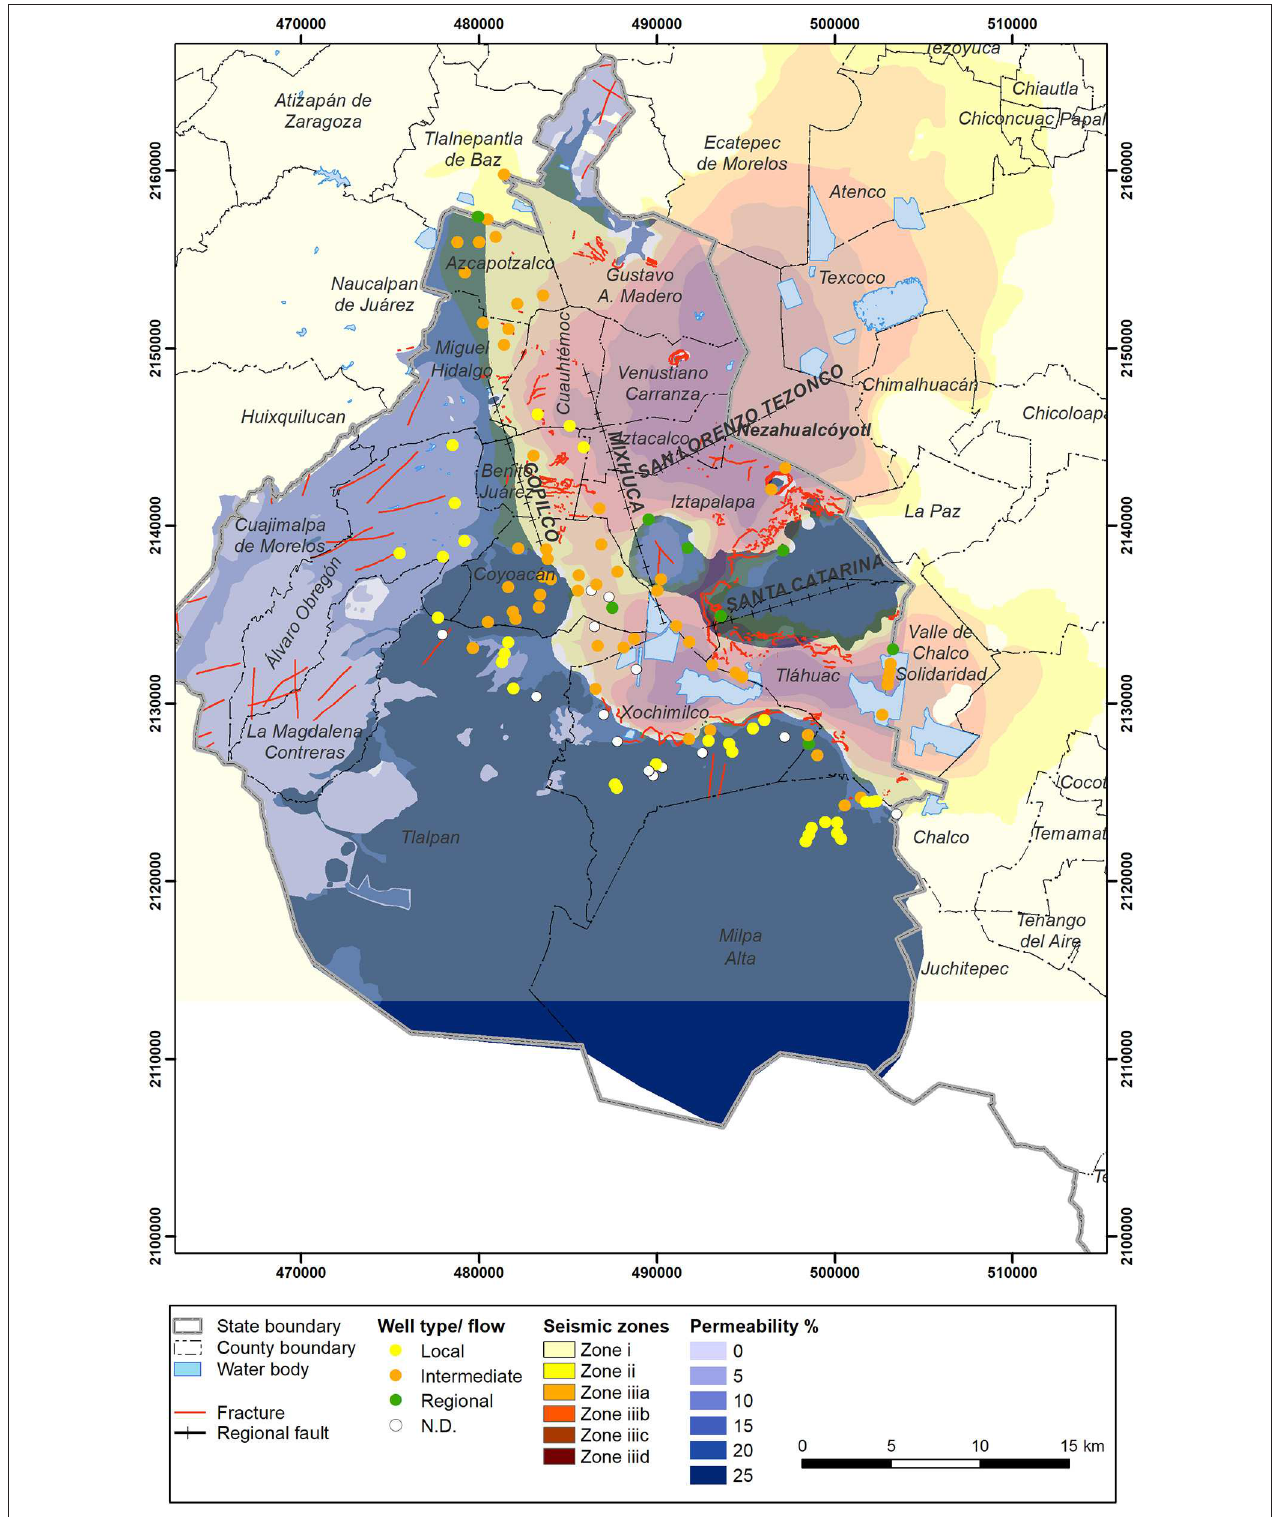
FIGURE 6 | Overlap of seismic zones with permeabilities and wells of different flows local (yellow), intermediate (orange), and regional (green).